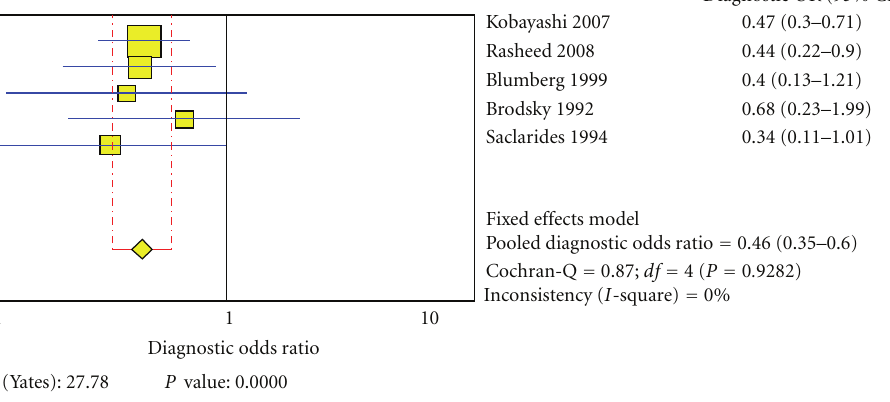
Figure 5: Risk of lymph node metastasis in Vascular Invasion.